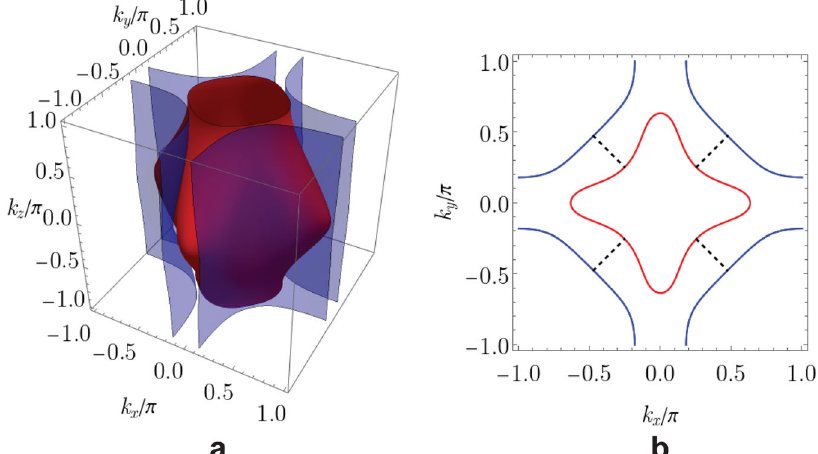
Fig. 5 Fermi surfaces for a minimal two-band model. a , b The two important Fermi surfaces of the 111-type materials can be qualitatively reproduced by a range of parameters in a minimal two-band model. Here, we set t ∥ = 1 eV, and use the values (normalized by t ∥ ): μ = − 1.5, t ⊥ = 0.70, t d = 1.25, t δ = 0.60, t m = 0.40, ε ð 0 Þ 0 : 45 , and ε ð 0 Þ 0 : 20 . The two corresponding Fermi surfaces are shown in a , while their 1 ¼ 2 ¼ (cid:2) projections on the k z = 0 plane are shown in b . The dashed lines in b depict schematically the interband nature of the pairing of